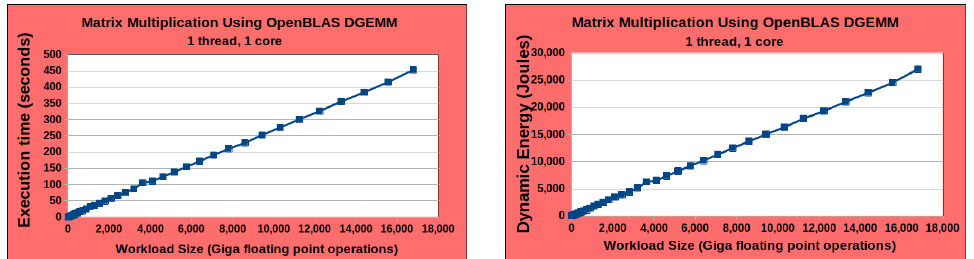
Figure 2. Execution time and dynamic energy profiles of OpenBLAS DGEMM application multiplying two square matrices of size n × n on a single core of the Intel Haswell multicore CPU shown in Figure 1. The application is multithreaded and uses only one thread during its execution. The workload size shown on the x-axis equals 2 × n 3 . The workload is shown in Giga floating point operations. The y- axis in the left-hand and right-hand plots show the execution time and dynamic energy consumption of the computations involved in matrix multiplication in the OpenBLAS DGEMM application. The execution time and dynamic energy profiles observed are linear functions of workload